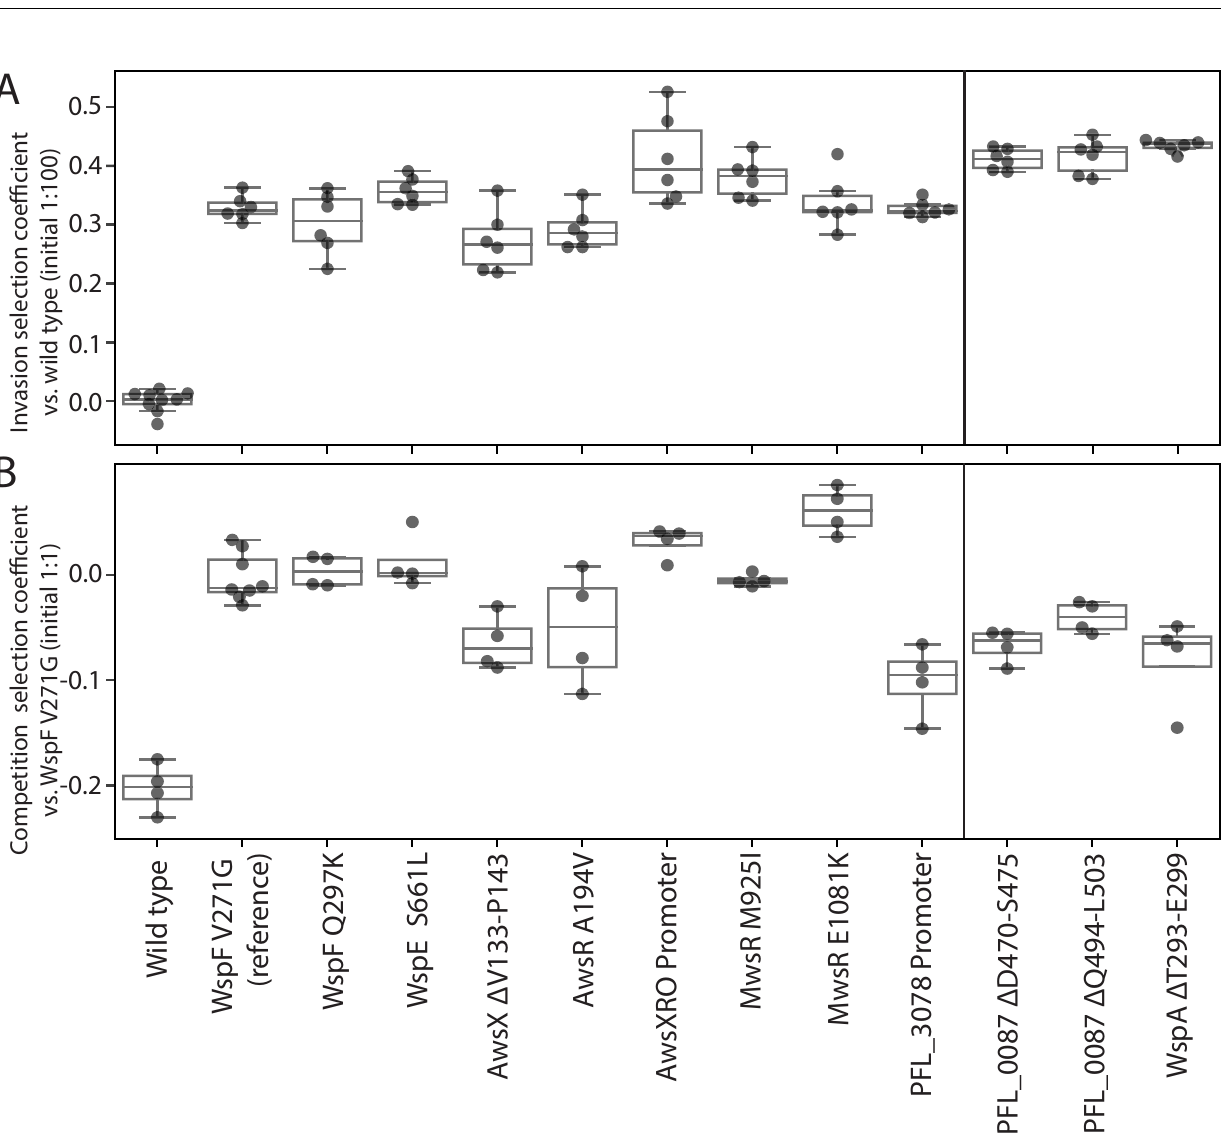
prediction further. To test if the Pel exopolysaccharide is the main structural component (Fig 1B) used by the different WS mutants of Pf-5 (Prediction 2), the pelABCDEFG operon (PFL_2972-PFL_2978) was deleted from Pf-5 and combined with previously characterized WS mutations and fitness was measured. Both invasion fitness (Fig 6A) and competition fitness (Fig 6B) were significantly lower (two-tailed t-tests p < 0.01) compared to isogenic strains with an intact pel operon (Fig 5A and 5B, average fitness of mutants with intact pel are plotted as red triangles in Fig 6 and S3 Table) except invasion fitness for the AwsX mutant (two-tailed t -tests p = 0.08, one outlier). Deletion of the pel operon in the absence of WS mutations did not significantly reduce fitness in invasion against the wild type (0.020 +/-0.050 (SD), two-